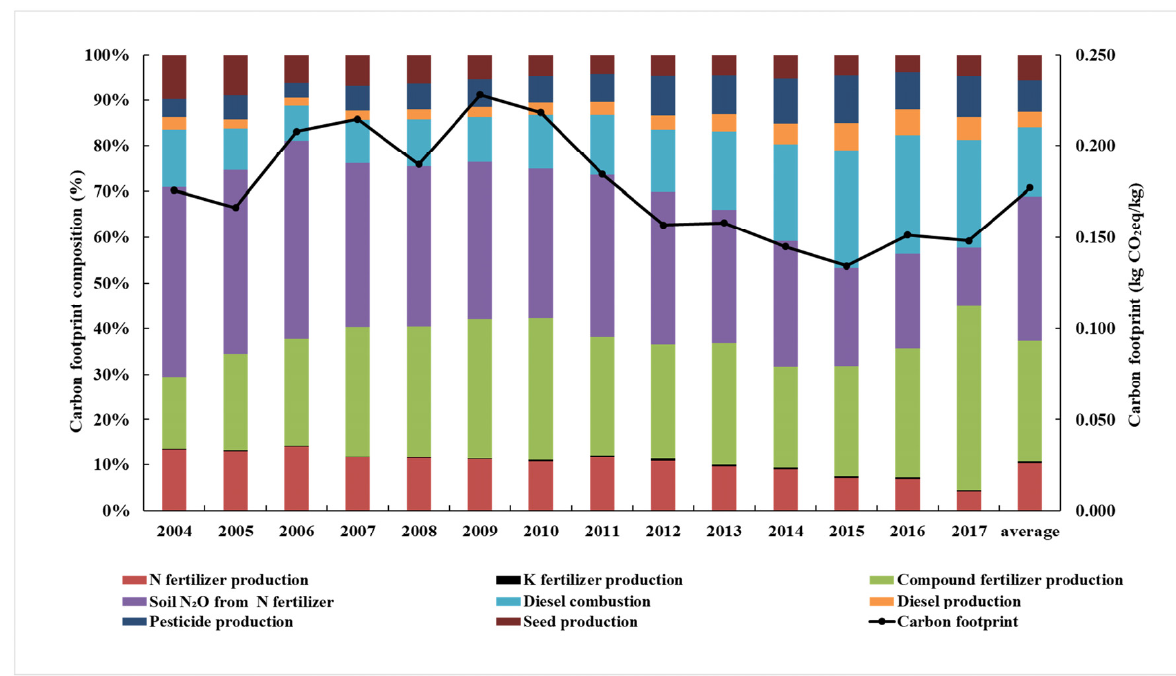
Figure 3. CFs and its composition of maize production in Jilin Province from 2004 to 2017. In the composition of the CF of maize production, the CFs associated with the pro- duction and transportation of fertilizer accounted for the largest share (37.28%), of which compound fertilizer accounted for 26.60%, N fertilizer accounted for 10.36%, and K fer- tilizer accounted for 0.32% (Figure 3); followed by the CF of the emission of N 2 O due to N fertilizer application, which accounted for 31.72% of the total CF. The CF of diesel combustion from agricultural machinery accounted for 15.06% of the total, and the CF of diesel production associated with transportation accounted for 3.30%. Pesticide input caused 6.89% of the total CF, and that caused by seed input was 5.75%. The CFs caused by compound fertilizer production, diesel combustion and pesticide input presented an increasing trend from 2004 to 2017, and the CFs from N fertilizer production, field N 2 O emissions and seed input decreased over the same